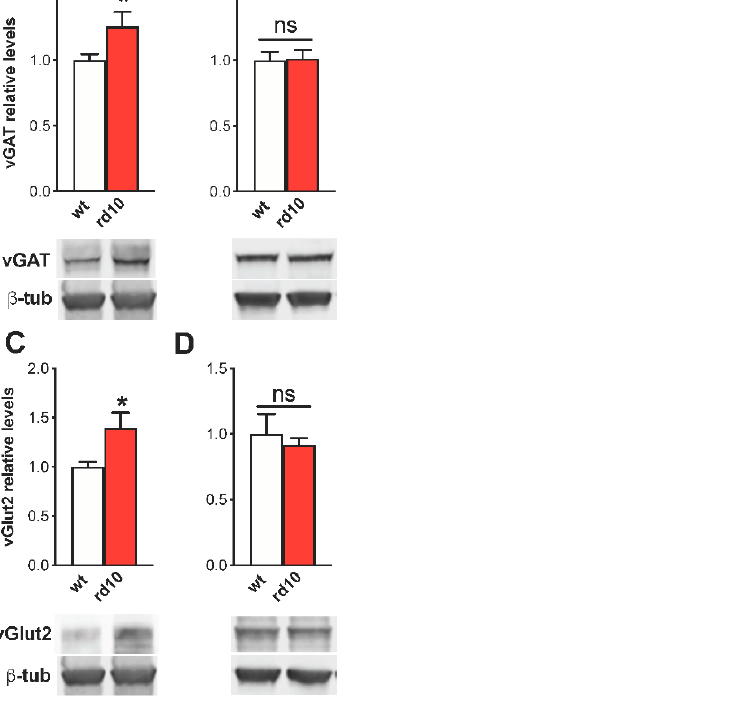
Figure 5. Alterations of vGAT and vGlut2 levels in the lateral geniculate nucleus (LGN) of rd10 animals at P60. In all panels, the inset is a representative immunoblotting showing the corresponding protein levels in the visual cortex of wild-type (wt) and rd10 transgenic animals. α -Tubulin ( α -tub) is the internal standard. Diagrams show the percentage value of protein expression in relation to the control (wt) group. ( A – C ) vGAT and vGlut2 levels were larger in LGN of rd10 mice at P60 ( n = 7) with respect to age-matched wt animals ( n = 8, t -test, p < 0.05 for both comparisons). ( B – D ) No difference was present in the superior colliculus (SC) for either vGAT ( n = 8 for both groups, t -test, p = 0.891) or vGlut2 ( p = 0.611) expression. Animals used for protein quantification in LGN and SC are the same as those shown for visual cortex data. One sample was removed from the rd10 group for LGN analysis because of the undetectability of the vGAT band. Data are expressed as mean ± s.e.m. * p < 0.05 and ns: not significant.